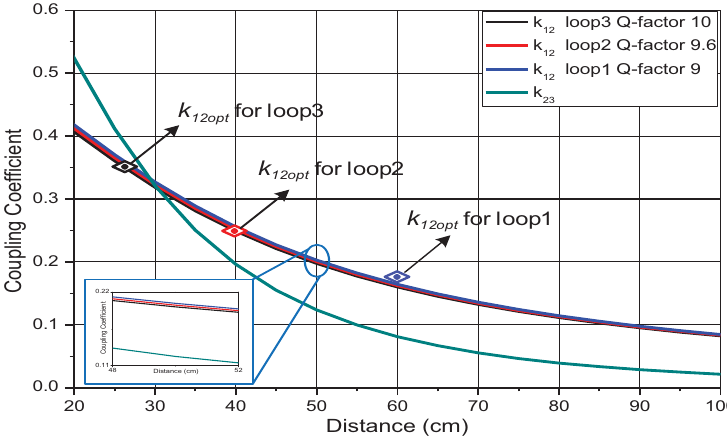
Figure 5. Computed k 12 opt for the Case 2 system for three different loops and k 23 for varying d 23 . The obtained k 12 for different loops are indicated with three points.